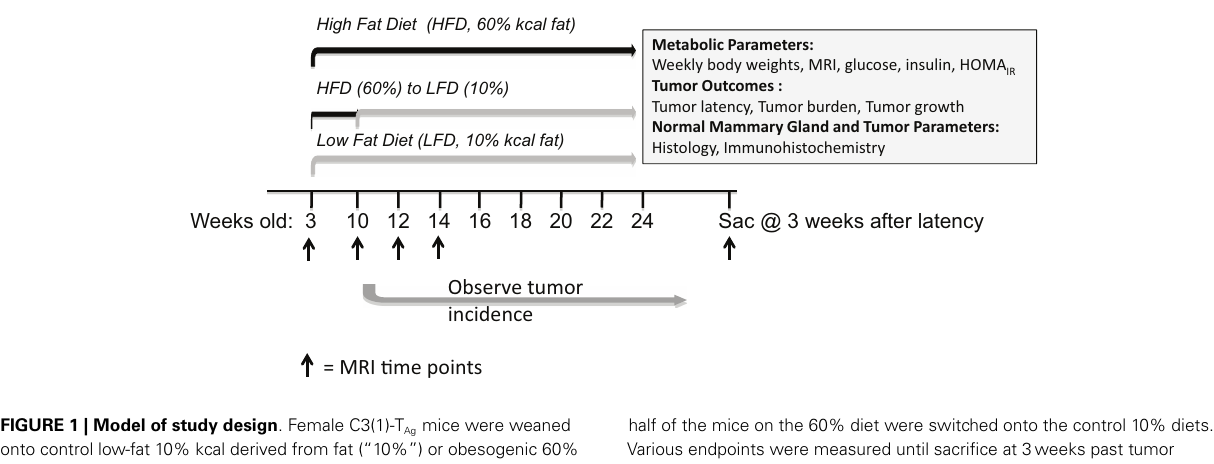
half of the mice on the 60% diet were switched onto the control 10% diets. Various endpoints were measured until sacrifice at 3weeks past tumor